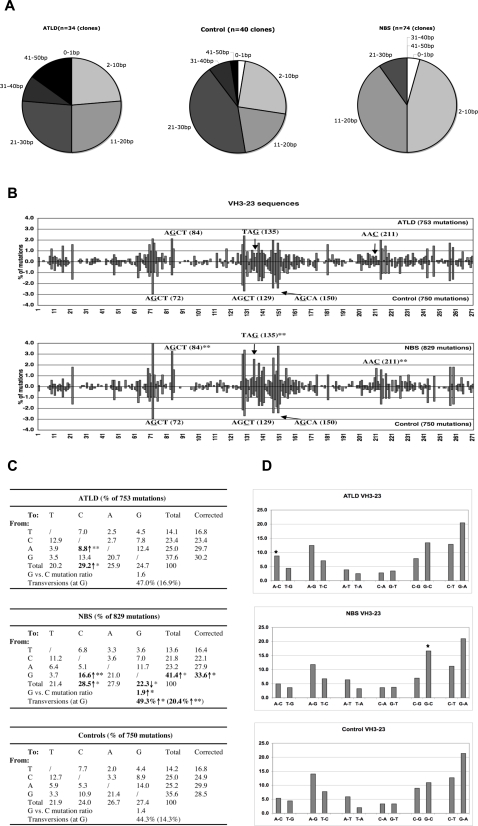
Pattern of mutations introduced in the VH3-23-Cγ transcripts.A). Pie charts demonstrate the proportion of clones carrying the indicated number of mutations. B). Distribution of mutations in VH3-23 in ATLD or NBS patients (above the zero line) and in controls (below the zero line). Nucleotides are numbered from the third base of codon 10 of the VH3-23 coding region. The percentage of mutations at each position (number of mutations at each position / total number of mutation) is plotted and the major hotspots in controls are highlighted. Several positions that show significantly more mutations in the NBS patients are also indicated. **p<0.01. C). Nature of the base substitutions in the VH3-23 genes. The germline sequence used for comparison contains 21.4% A, 31.7% G, 21.4% T and 25.5% C. Correction: values presented in the column were corrected to represent sequences with equal amounts of the four nucleotides. Statistical analysis was performed using χ2 test. Numbers that are significantly different from controls are bolded. *p<0.05; **p<0.01. ↑, significantly increased; ↓, significantly decreased. D). Percent distribution of each type of nucleotide substitution. Individual substitutions are paired together with their complementary mutations. Mutations in ATLD or NBS VH3-23 sequences were compared with the control VH3-23 transcripts. Stars indicate that the proportion of a given substitution when it is significantly different in patients as compared to the controls.